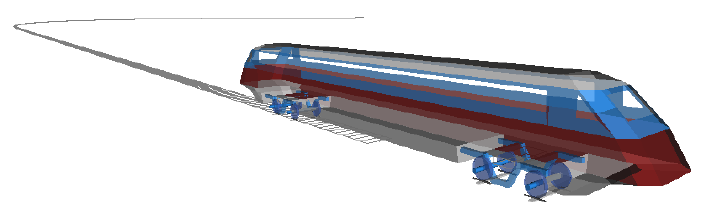
Figure 1. Vehicle–track system dynamics model. Figure 1. Vehicle – track system dynamics model. Table 1. Vehicle–track model parameters. Table 1. Vehicle – track model parameters.